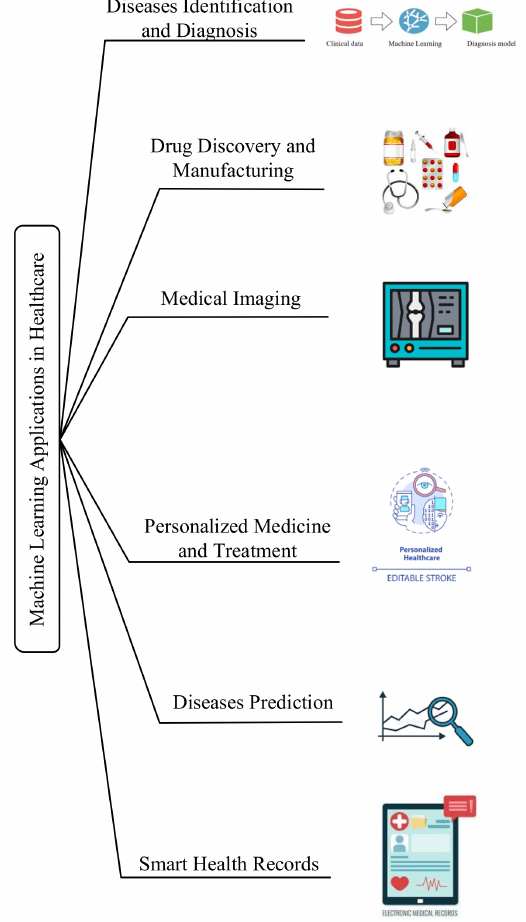
Figure 2. Various ML applications in